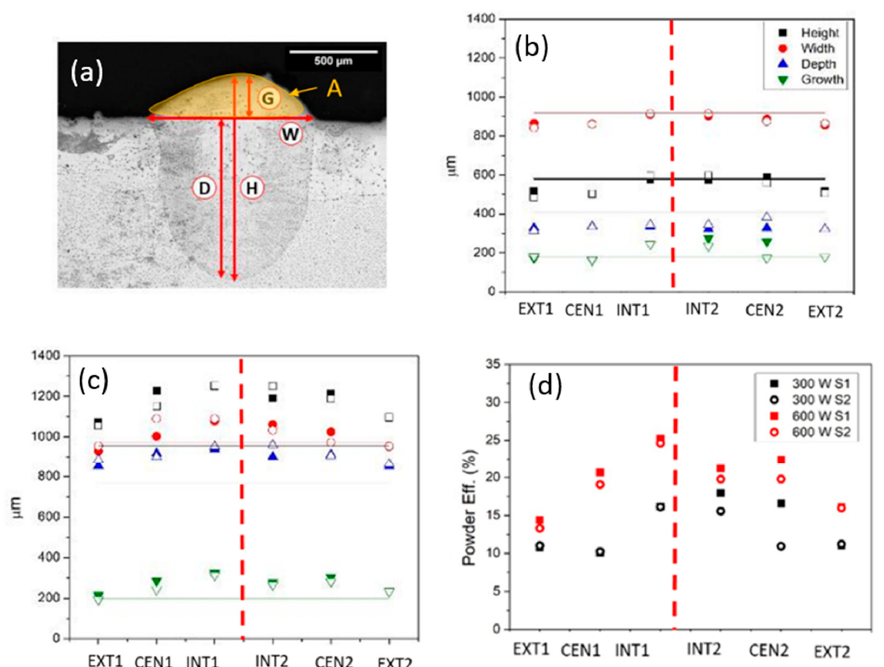
Figure 5. ( a ) Schematic representation of a metal bead with the geometrical features, ( b ) geometrical features of circular contour samples realised with ( b ) 300 W and ( c ) 600 W (S1 solid and S2 open symbols). Continuous lines represent the geometrical feature of the single scan track obtained with the same parameters. ( d ) Powder efficiency ( P e ) of circular contour melt pool.